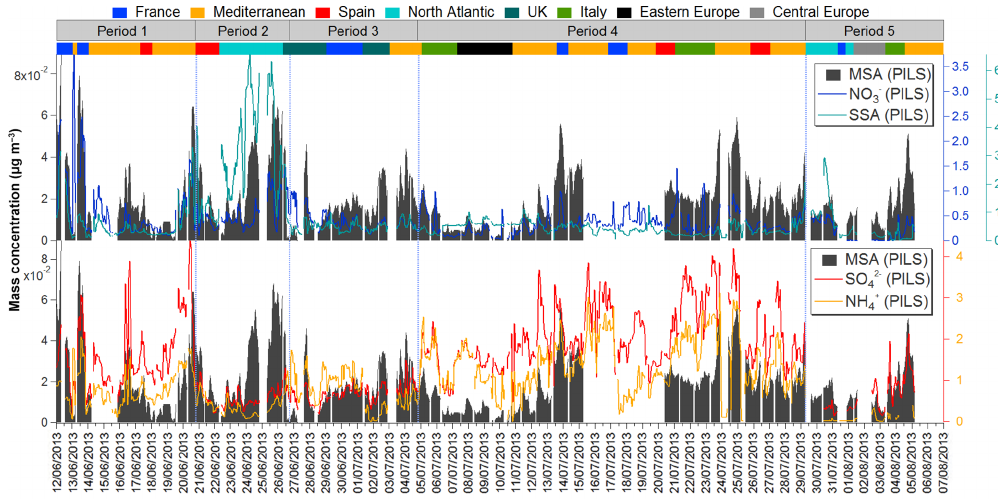
Figure 12. Hourly mass concentrations of PILS-IC species MSA (methanesulfonate), NO − ADRIMED and SAF-MED. Dates are